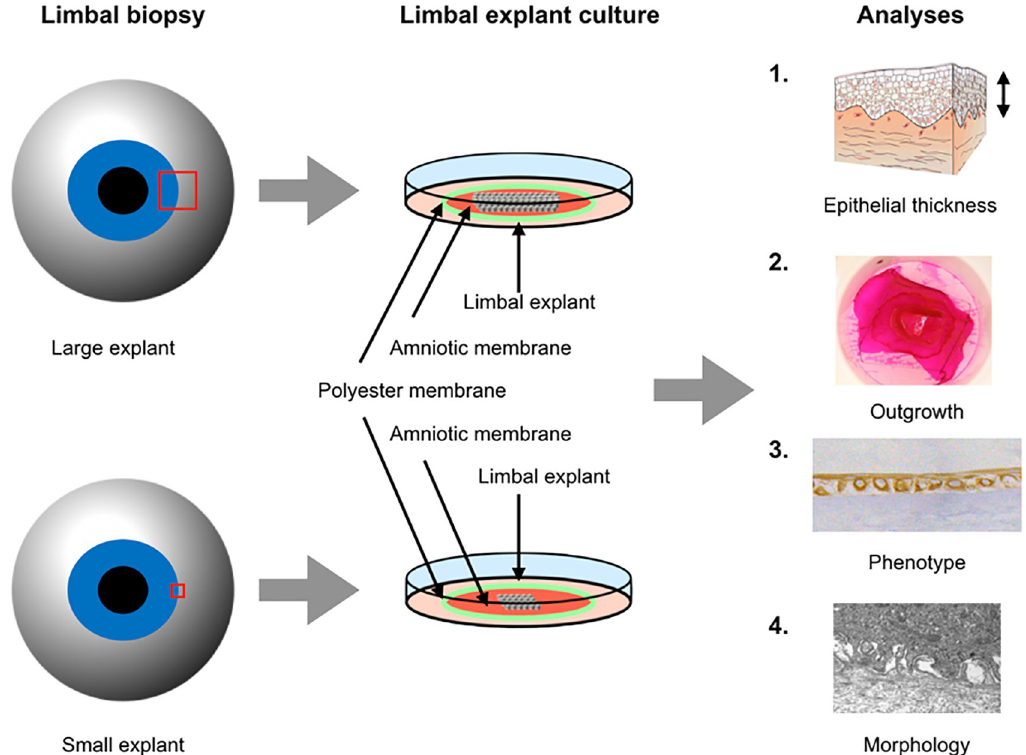
stratification, outgrowth, phenotype and morphology were compared between the